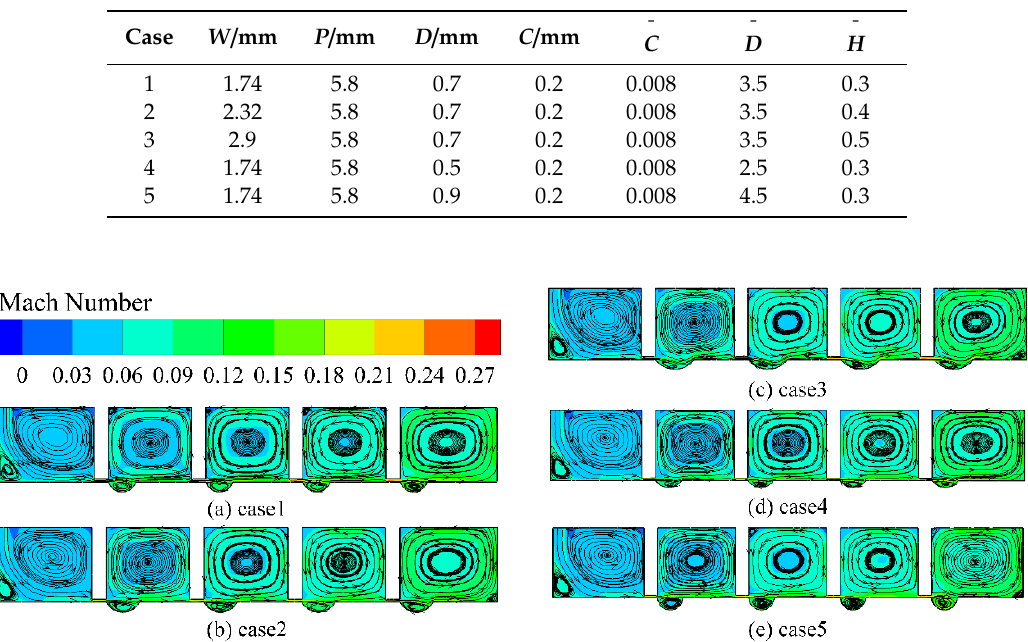
Table 5. Configurations of circle grooves.